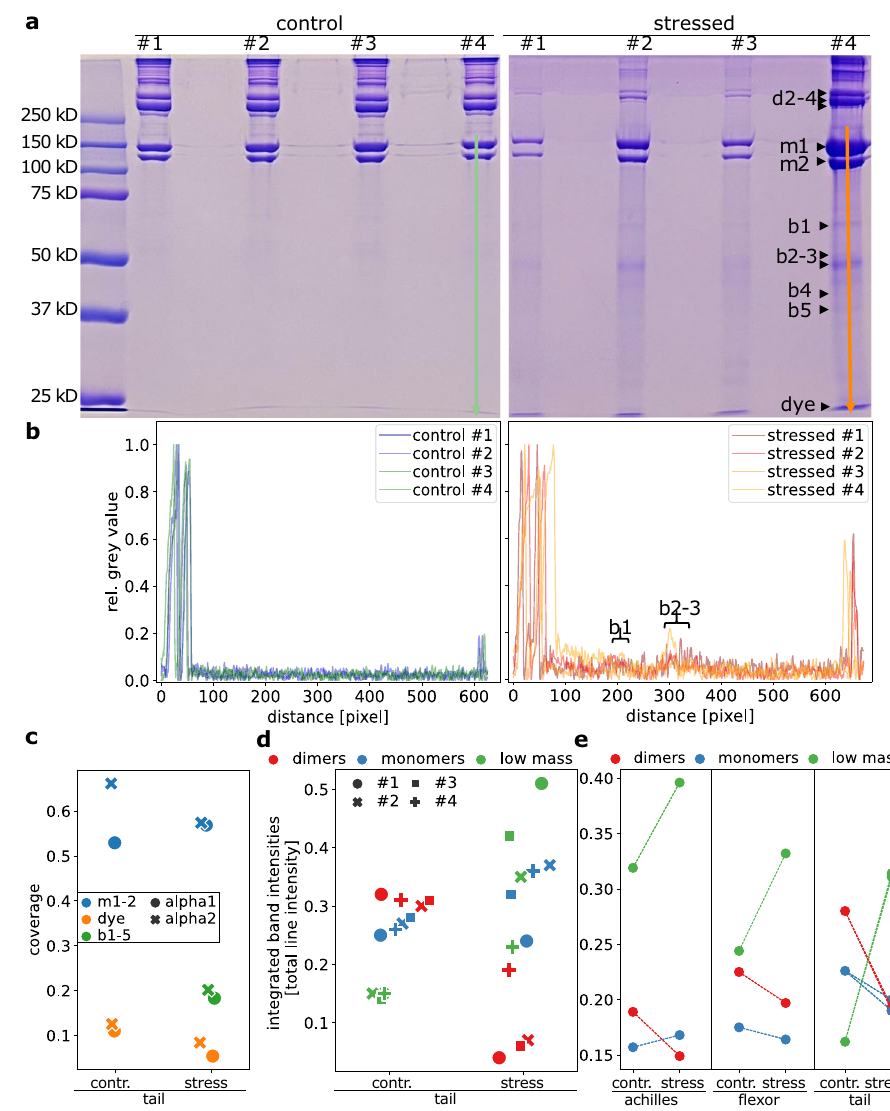
Fig. 5 | Experiments support the simulations of covalent backbone and crosslink rupture in stressed tendon collagen. a SDS-PAGE analysis reveals alteredpatternsofbandsandtheirintensitiesbetweenstressedandcontroltendon collagen. The four lanes are technical repeats, the experiment was repeated inde- pendently for a second biological sample set, see Supplementary Fig. 10. We indi- cate lines used for analysis in panel b in lane #4. The bands b1 – 5, cut out for the mass spectrometry, are marked with arrows. b Densitometry to quantify stained collagen α -chainsanddegradationproductsonSDS-PAGE.Weshowthenormalized inverted grayvalue along the lanes. c Percent sequence coverage of collagen α 1(I)-